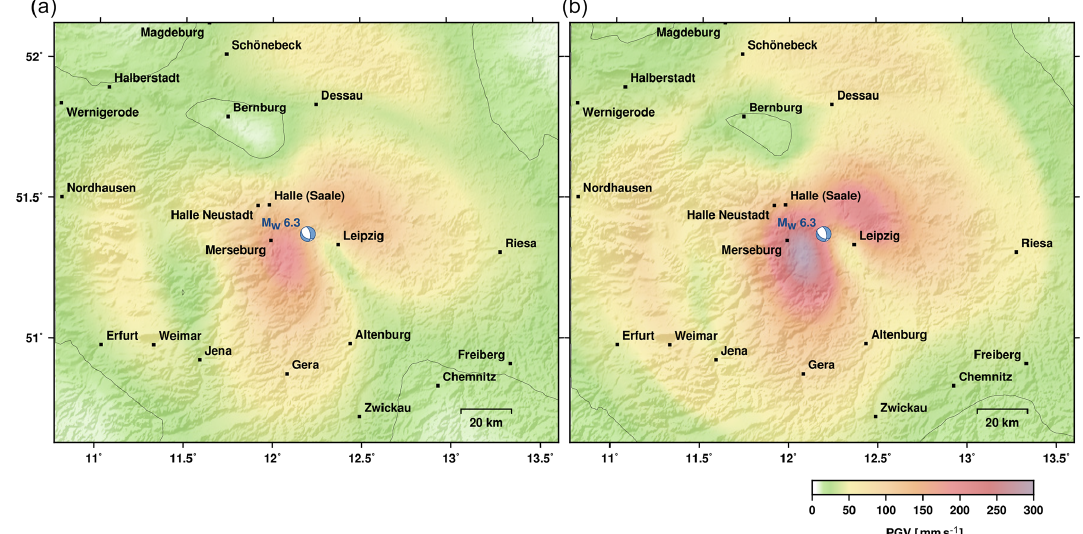
Figure 5. Shake map scenario of a M W 6.3 characteristic lower-crust earthquake at 25km of depth between Halle and Leipzig, Germany. (a) Predicted PGV 6Hz assuming a hard rock upper-layer model. (b) Predicted PGV 6Hz assuming a 500m thick soft layer beneath the surface with P- and S-wave velocities of 2.5 and 1.2kms − 1 , respectively. The contour line shows the 20mms − 1 threshold (see Dahm et al., 2018, for further explanation).